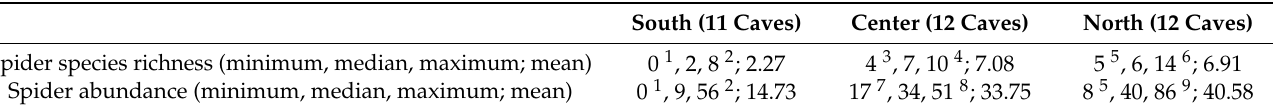
Spider species richness (minimum, median, maximum; mean) Spider abundance (minimum, median, maximum;